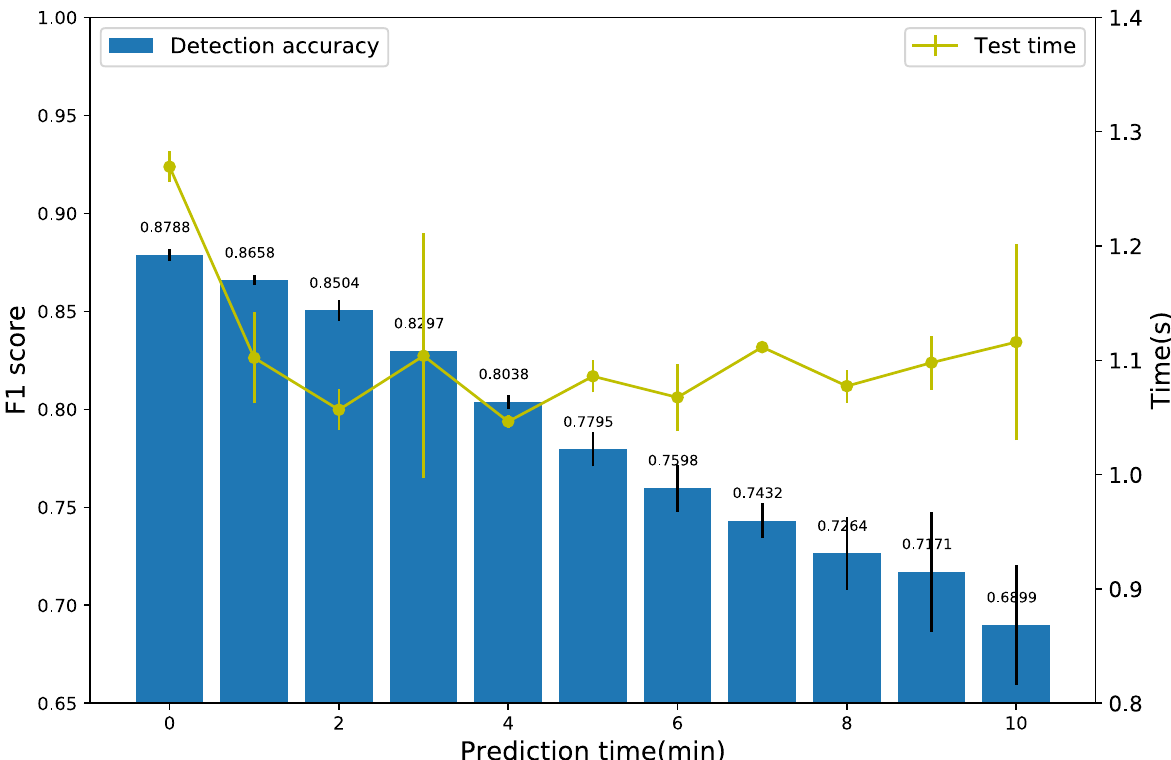
Fig. 6 Prediction accuracy and time spent for different time steps of the deep ensemble method on the DApp monitoring data